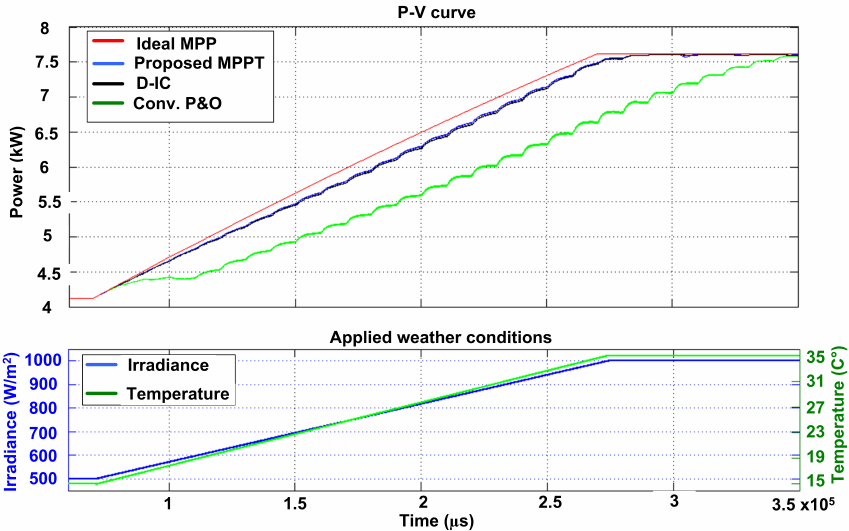
Figure 11. Case 2: Response of three algorithms against linear increment in weather conditions.